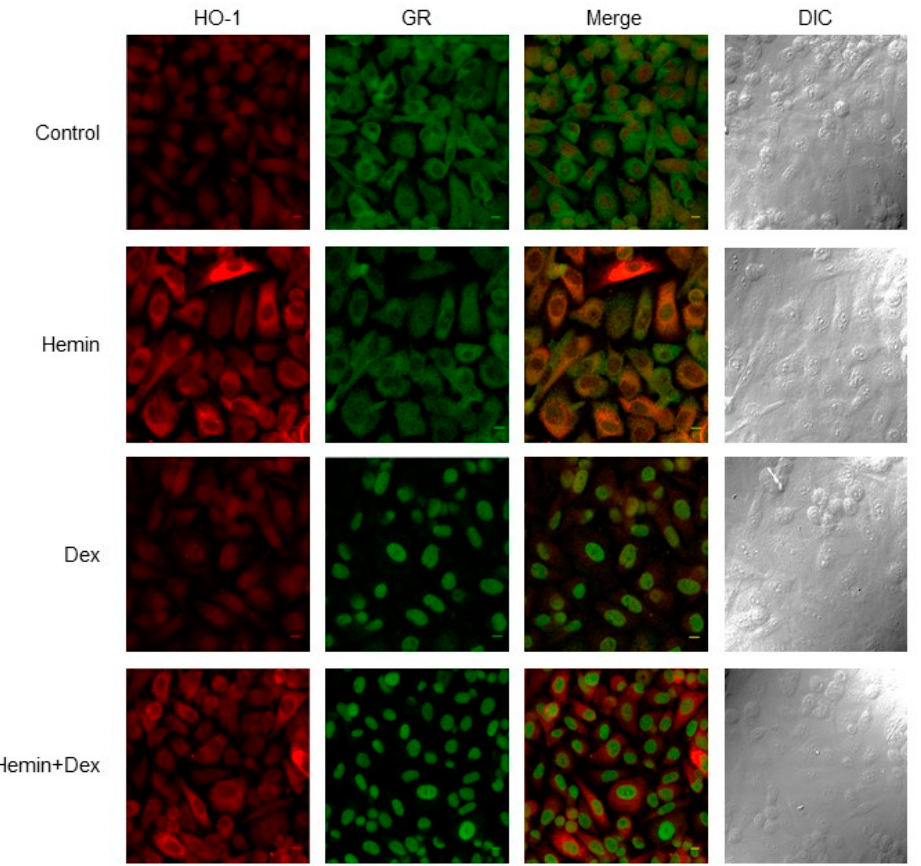
Figure 3. Analysis of HO-1 and GR subcellular localization. Immunofluorescence analysis of HO-1 and GR expression and localization in PC3 cells treated with Hemin (80 µ M for 24 h), Dex (10 nM for 6 h post Hemin/PBS 24-h treatment), and the combination of both drugs or PBS as control. Cells were fixed, stained with anti-HO1, and anti-GR primary antibodies and secondary antibodies conjugated with Alexa Fluor 488 (red, HO-1) and 555 (green, GR) antibodies. Cells were imaged by confocal microscopy using the same parameters for all the treatments. A representative image for each condition is shown. Final magnification: x60